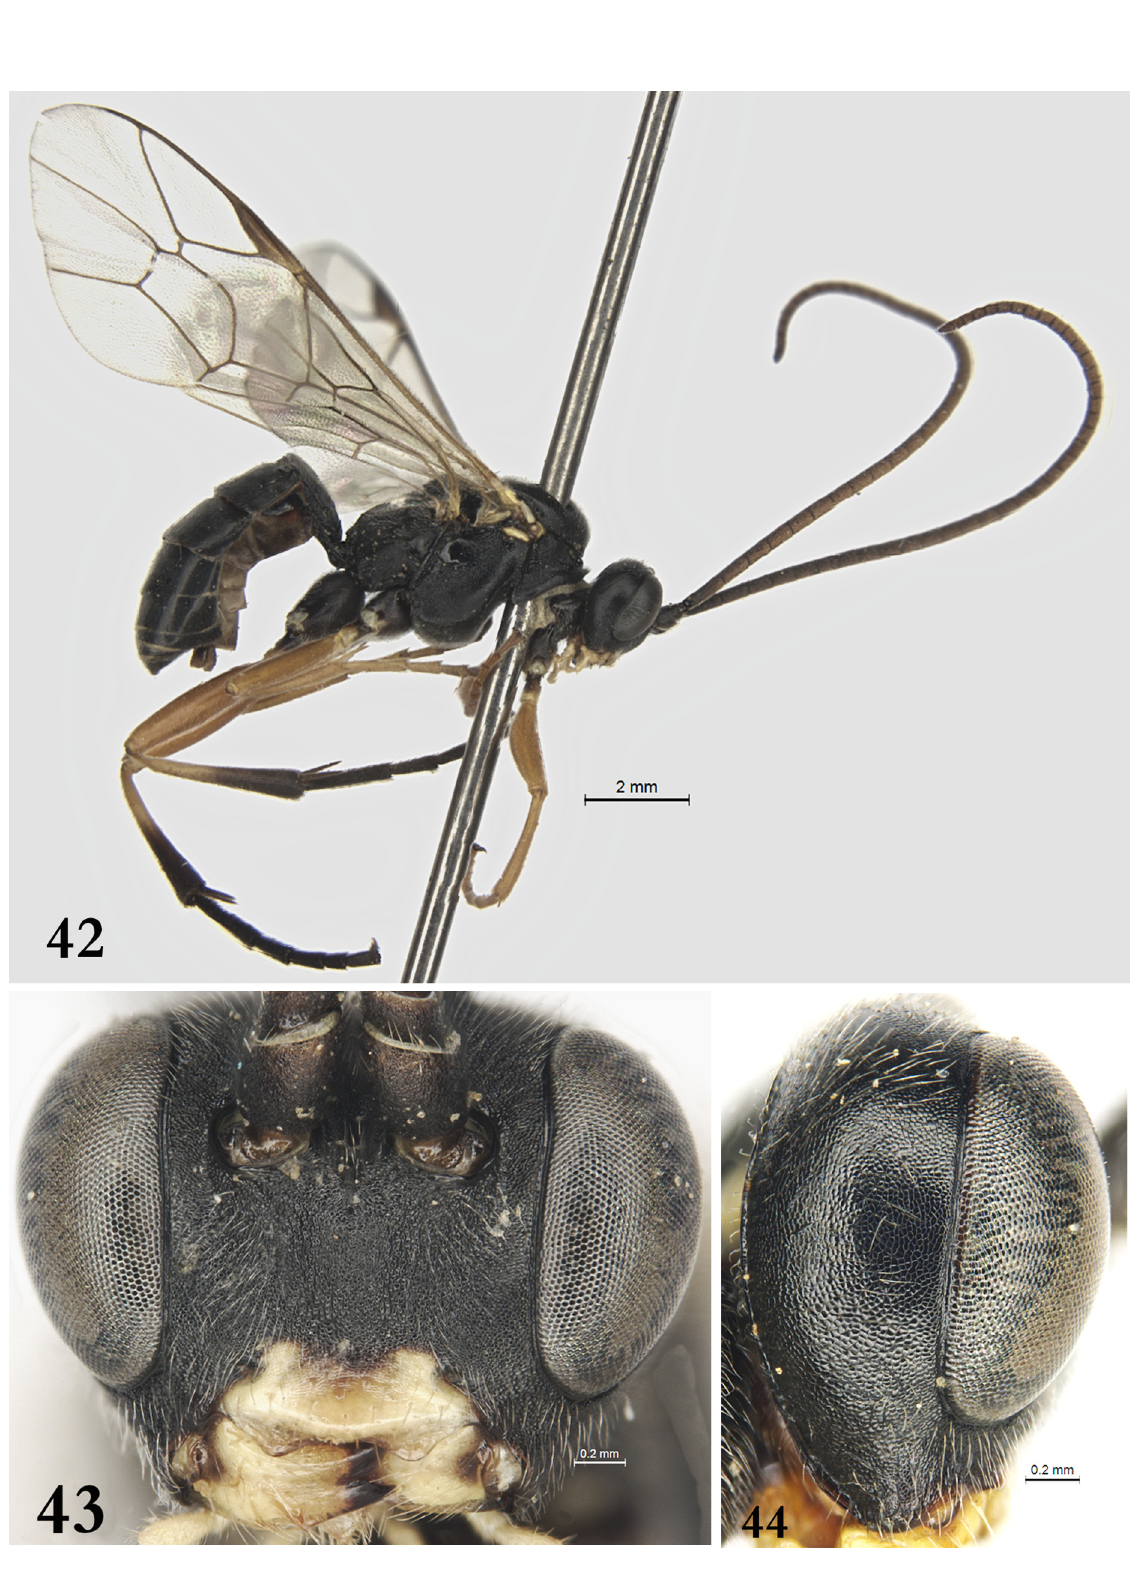
Figs 42–44. Campodorus truncatus Sheng, Sun & Li sp. nov., holotype, ♀ ( GSFGPM). 42 . Habitus, lateral view. 43 . Head, anterior view. 44 . Head, lateral